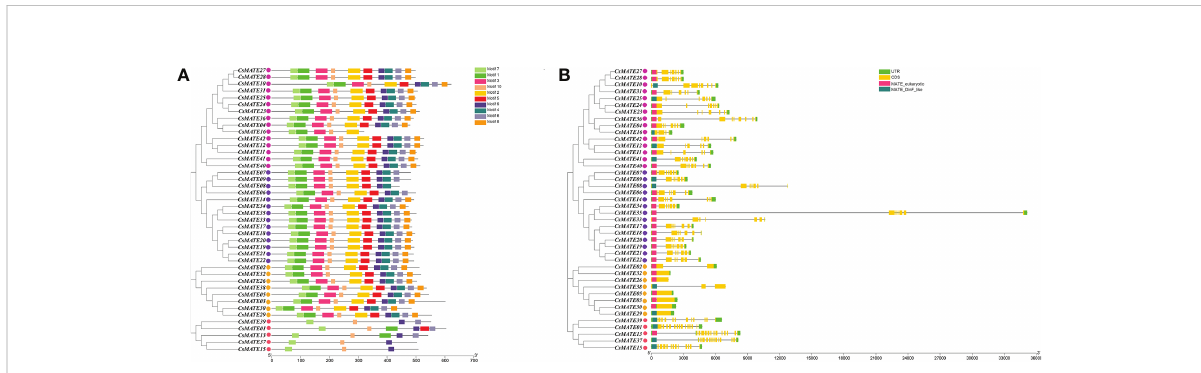
FIGURE 3 Conserved motifs and gene structure of CsMATEs. (A) CsMATEs Phylogenic tree and motifs distributions. Motifs are indicated as top right. (B) Gene structure and domain distribution. UTR, untranslated region; CDS, coding region; yellow boxes, exons; gray lines, introns; pink boxes, MATE eukaryotic domains; dark green boxes, DinF like domain. Purple dots indicates CsMATE from subfamily I; rose red dots, Subfamily II; pink dots, subfamily III; yellow dots, subfamily